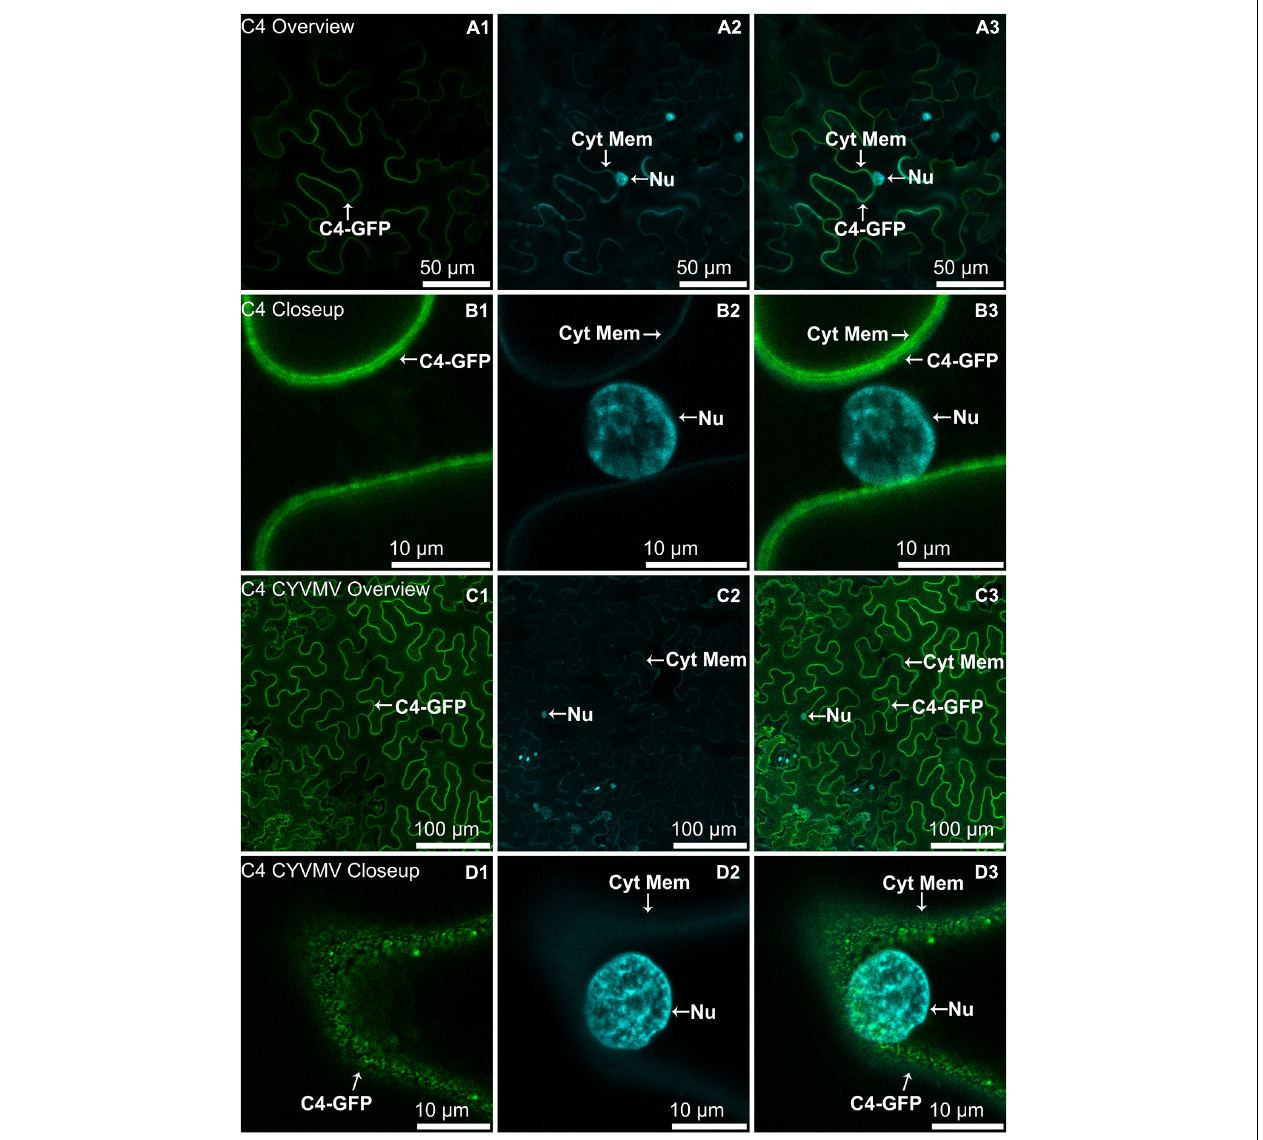
FIGURE 5 | Subcellular localizations of CYVMV, C4-GFP in N. benthamiana leaves under stand-alone (A,B) and CYVMV-inoculated (C,D) conditions. Panels (A,C) were taken under lower zoom, while panels (B,D) were taken with higher zoom. Images showing GFP fluorescence (A1,B1,C1,D1) and Hoechst fluorescence (A2,B2,C2,D2) . Merged images of both GFP and Hoechst fluorescence were shown as panels (A3,B3,C3,D3) . The C4-GFP localization appeared to be consistently in the plasma membrane with or without CYVMV inoculation. CYVMV can induce the aggregation of C4-GFP into small particles within the membrane. Arrowheads indicate the locations of C4-GFP and major sub-cellular organelle (Nu: nucleus; Cyt Mem, cytoplasmic membrane).